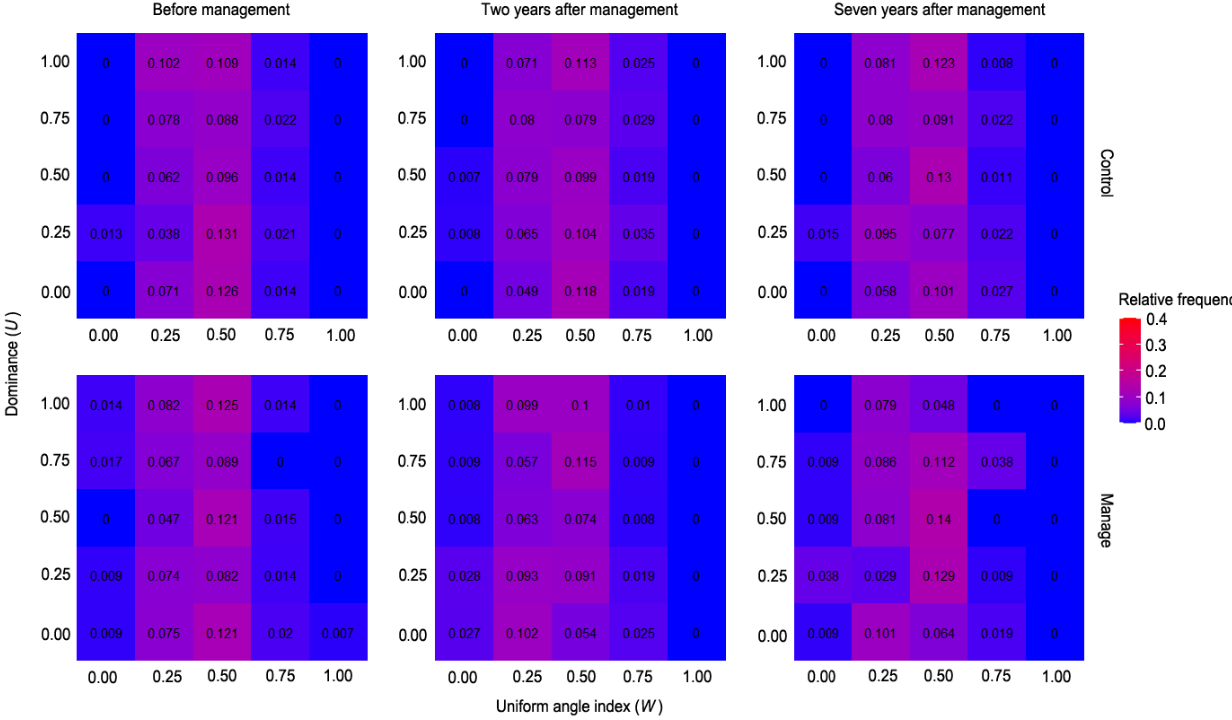
Figure 4. Bivariate distributions of 𝑊 and 𝑈 at different management years.